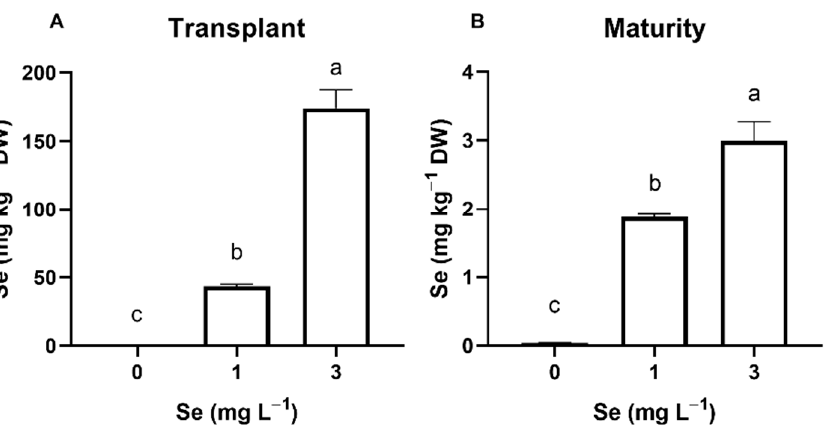
Figure 2 . Selenium (Se) content in lettuce plants, measured at transplant ( A ) and maturity ( B ), treated with different concentrations of Se at pre-transplanting. Means ( n = 3) flanked by different letter are statistically different for p = 0.05 after Tukey ’ s test.